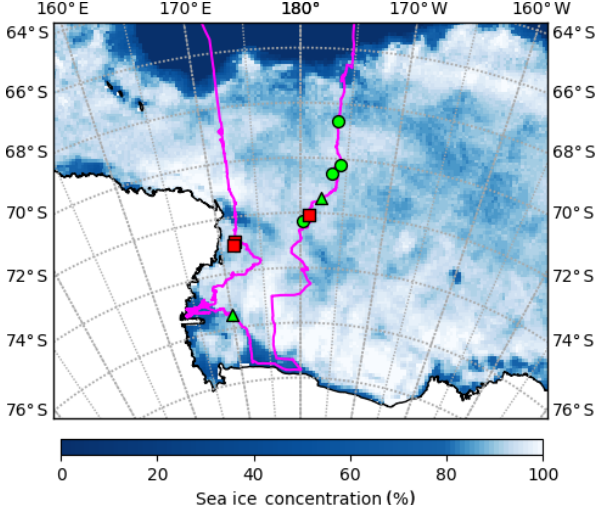
Figure 3. PIPERS track (magenta) with locations of ice stations labeled. Stations with AUV scans are shown in green (3, 4, 6, 7, 8 and 9) and the other stations (1, 2 and 5) are shown with red squares. Stations 4, 7, 8 and 9 (green circles) also have a snow freeboard scan and snow depth measurements; these are shown in Fig. 4. Other stations have some combination of missing lidar, AUV and snow data. Station dates were 14 May for station 3, 24 May for station 4, 27 May for station 6, 29 May for station 7, 31 May for station 8 and 2 June for station 9. Overlain is the sea ice concentration data (5d median) for 2 June 2017 from ASI-SSMI (Kaleschke et al., 2017). depth on top of ice (Sturm and Holmgren, 2018; Eicken and